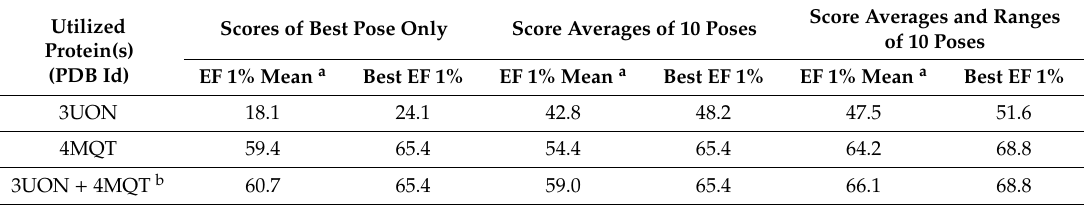
Table 1. Predictive performances of the generated models based on the performed virtual screening simulations as encoded by the highest and the average Enrichment Factor (EF) 1%